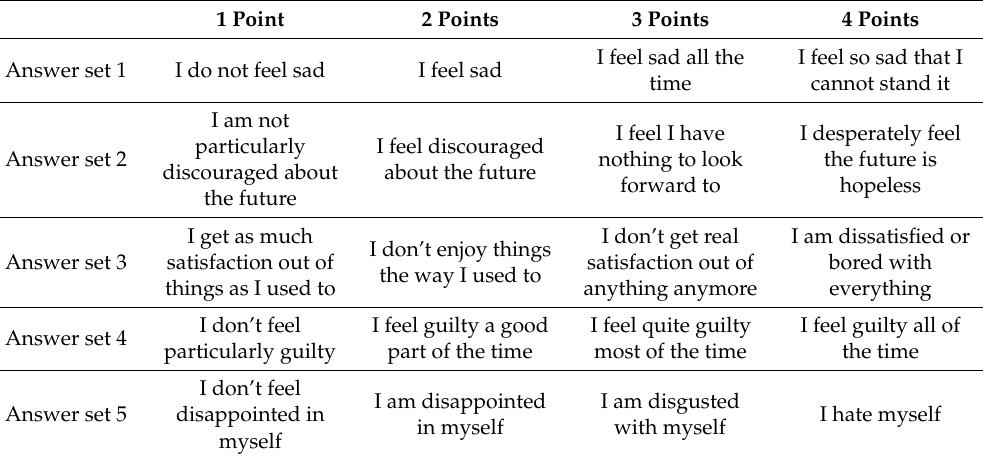
Table 1. Operationalization of